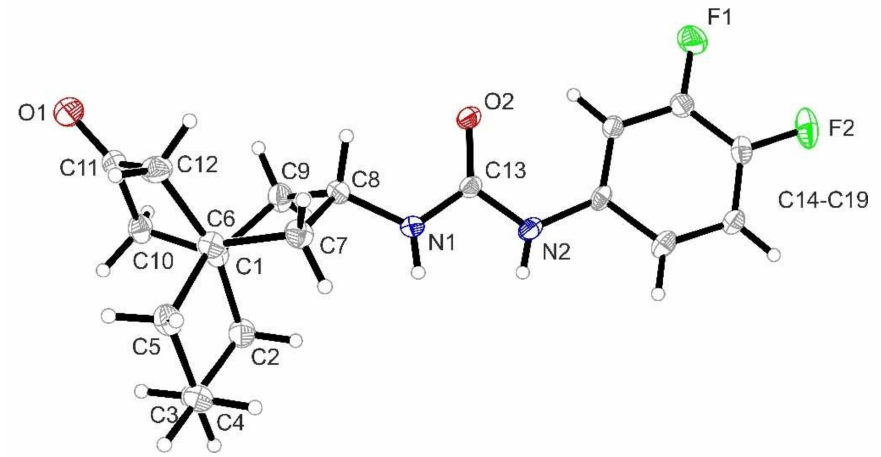
Figure 9. X-ray crystal structure of unsubstituted urea syn - 25 . Thermal ellipsoids are set at 15% probability. Selected bond lengths: C1–C6 = 1.546(3) Å; C1–C2 = 1.529(4) Å; C1–C9 = 1.548(4) Å; C1–C10 = 1.517(3) Å. CCDC number: 2073470. Only one molecule (molecule A) of three independent molecules found in the asymmetric unit is